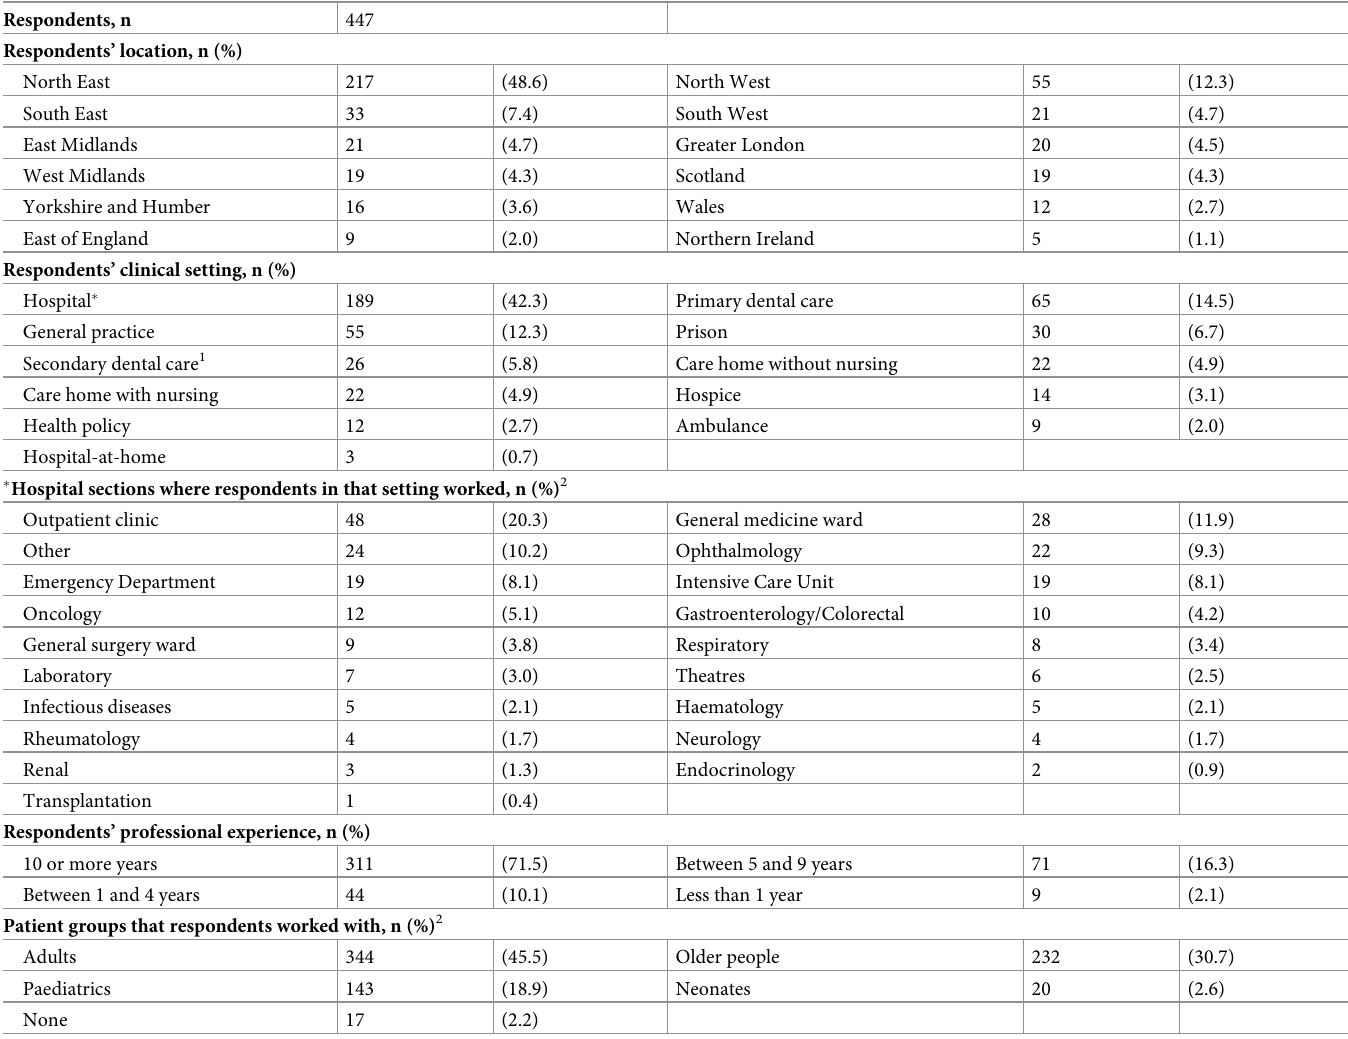
Table 1. Characteristics of survey